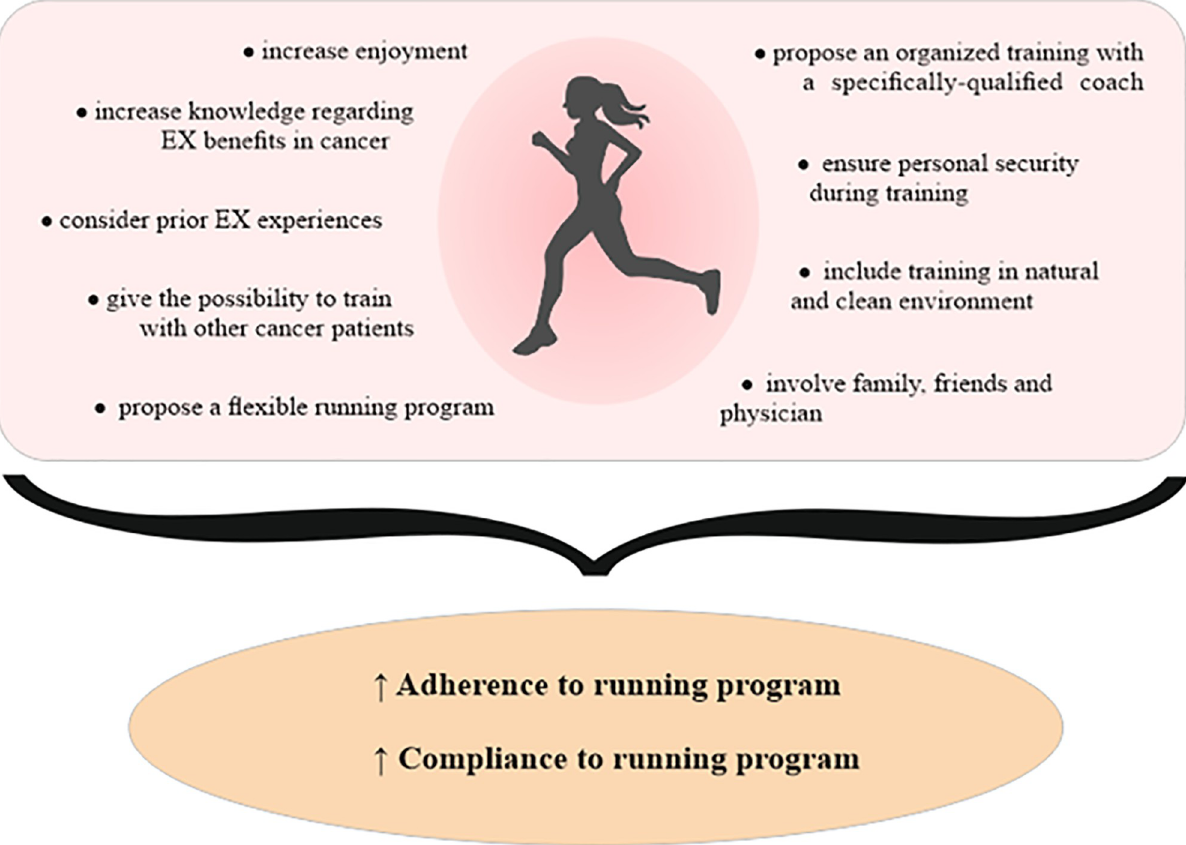
Fig 1. Strategies to increase adherence and compliance in a running